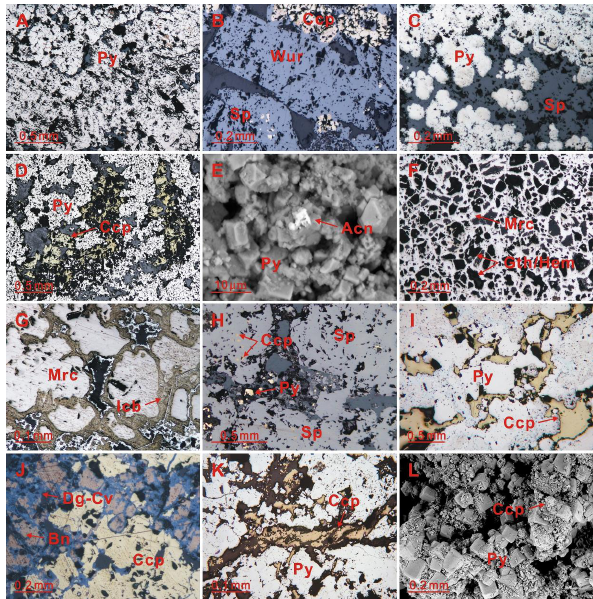
Figure 2. Figure 2. Reflected-light and SEM photomicrographs of typical sulphide ore types (polished thin sections or small fragments of ore specimens) from the Mid-Ocean Ridge hydrothermal